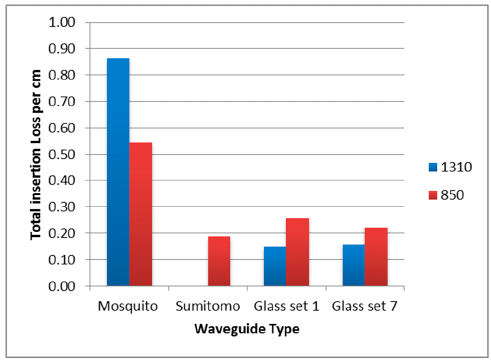
Figure 11. Total insertion loss per cm including coupling loss.